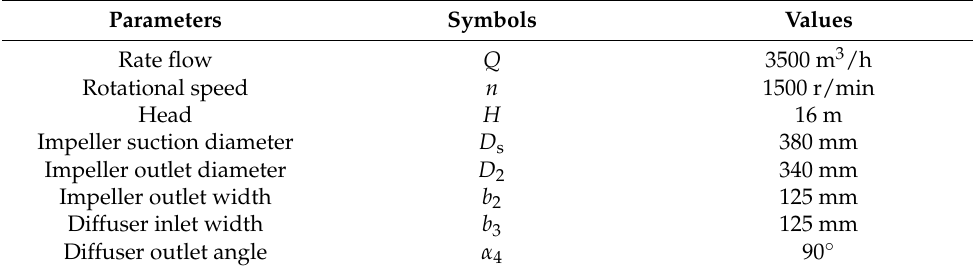
Figure 1. Structure of Mixed Flow Pump. Table 1. Design specifications of the mixed flow